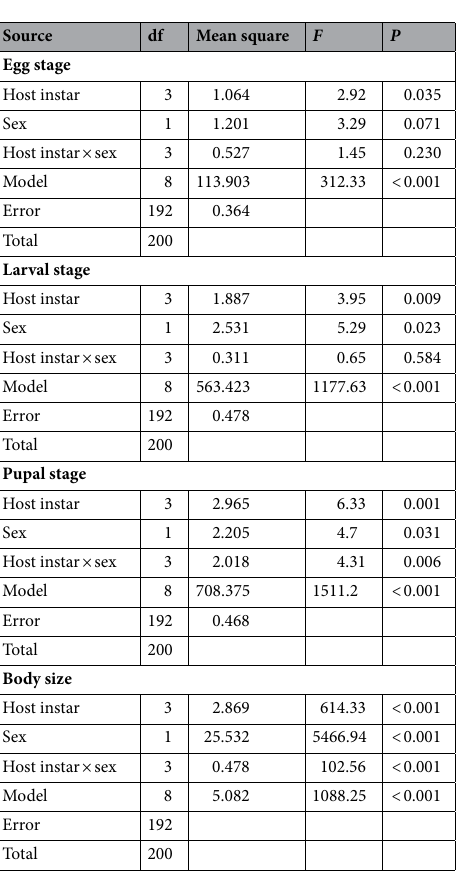
Table 2. ANOVA results of the developmental times of eggs, larvae, and pupae and body sizes of female and male offspring of Necremnus tutae on different instar hosts of Tuta absoluta